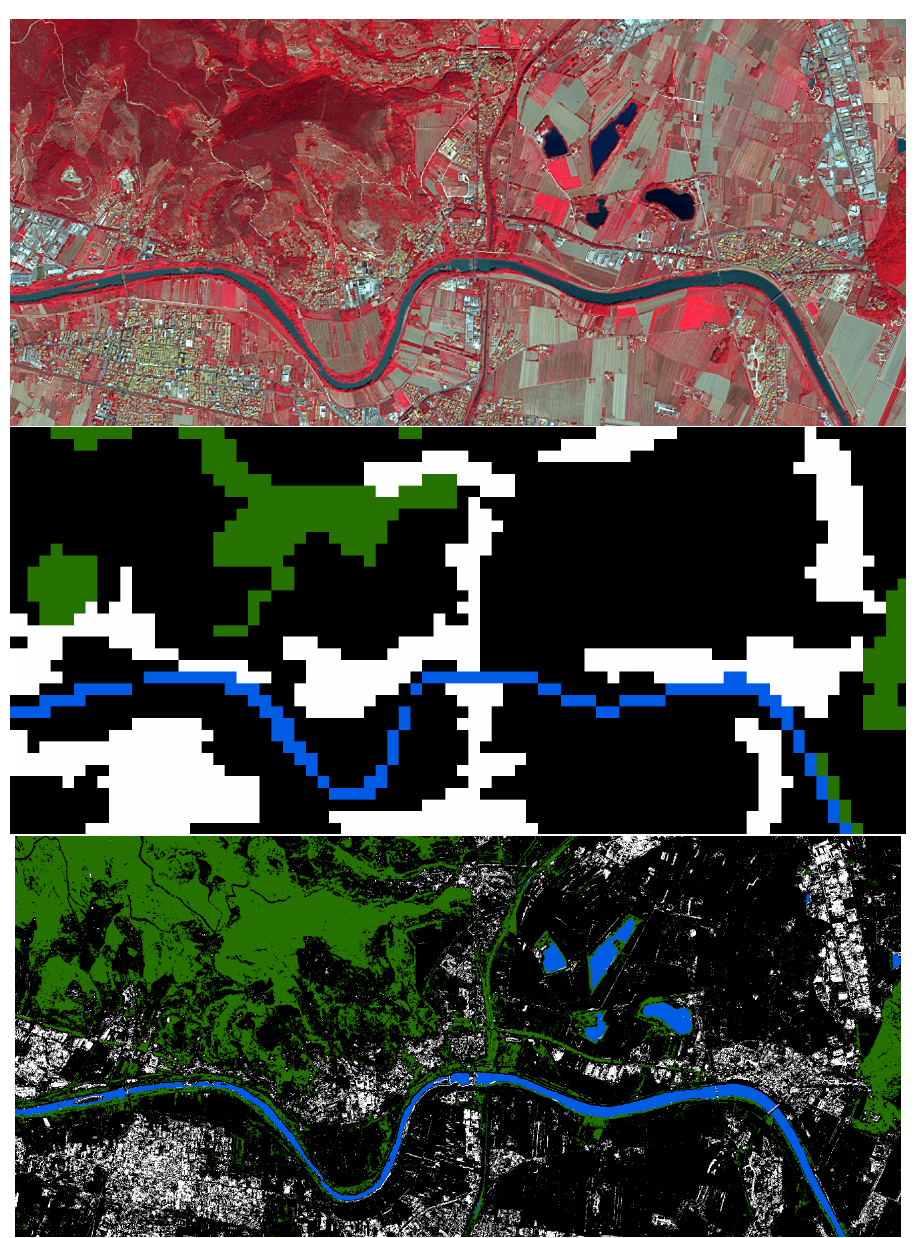
Figure 3. The SML classification. Top : input data in “false color” composite; center : classes of the reference set extracted from the CLC source at a 100-m spatial resolution: water (blue), generic forest (green), generic urban (white) and other (black); bottom : result of SML classification at a 2.5-m spatial